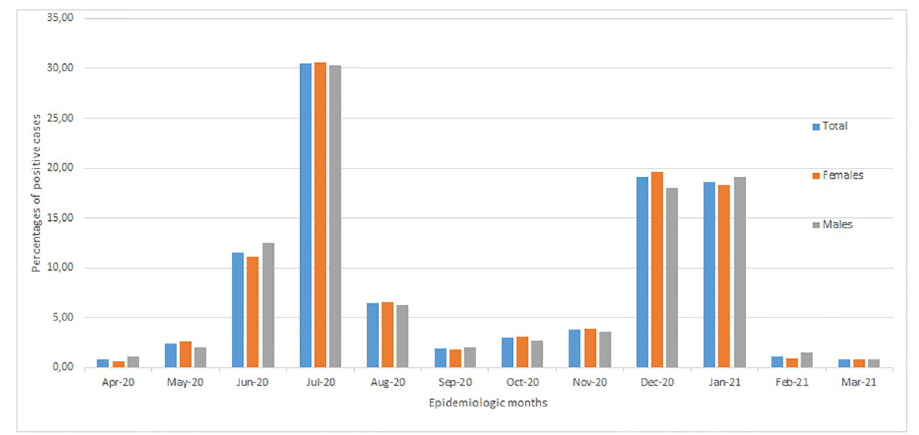
Fig 2. Monthly number and proportion of infections and incidence rates among the medical laboratory services staff by sex, 1 April 2020–31 March 2021.